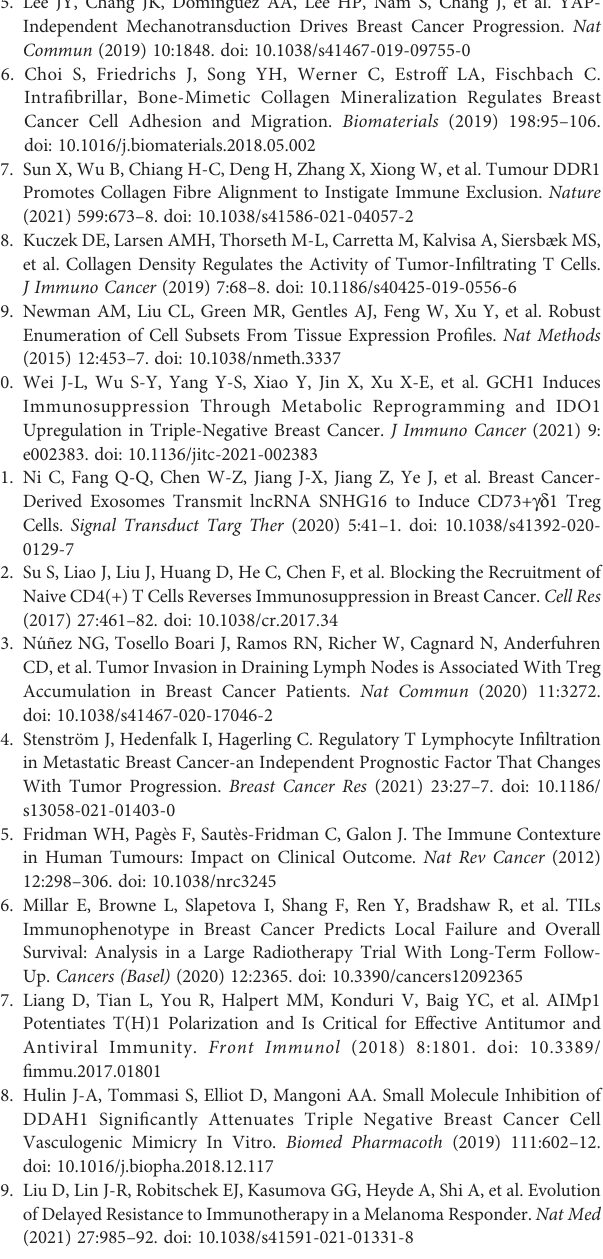
Supplementary Figure 3 | Immuno fl uorescence staining of CD4 and CD25 in Jurkat T cells encapsulated in different collagen